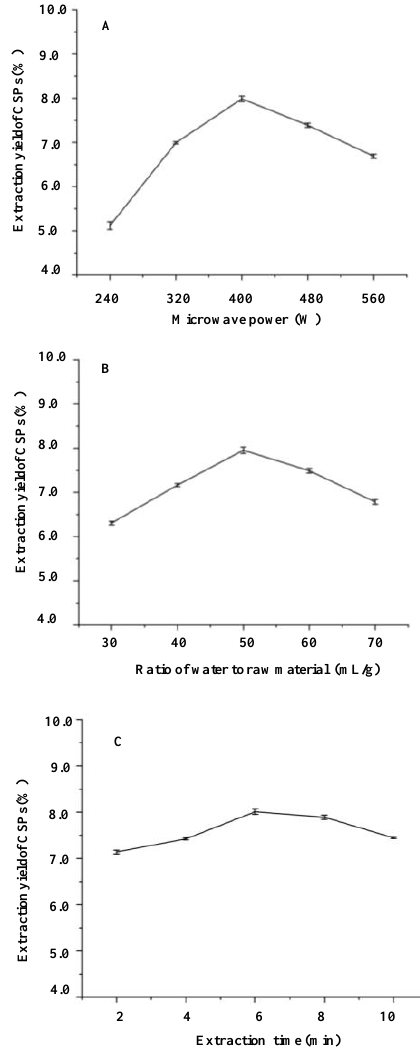
Figure 1. Effect of different microwave power ( A ), ratio of water to raw material ( B ), extraction time ( C ) on the extraction yields of CSPs.